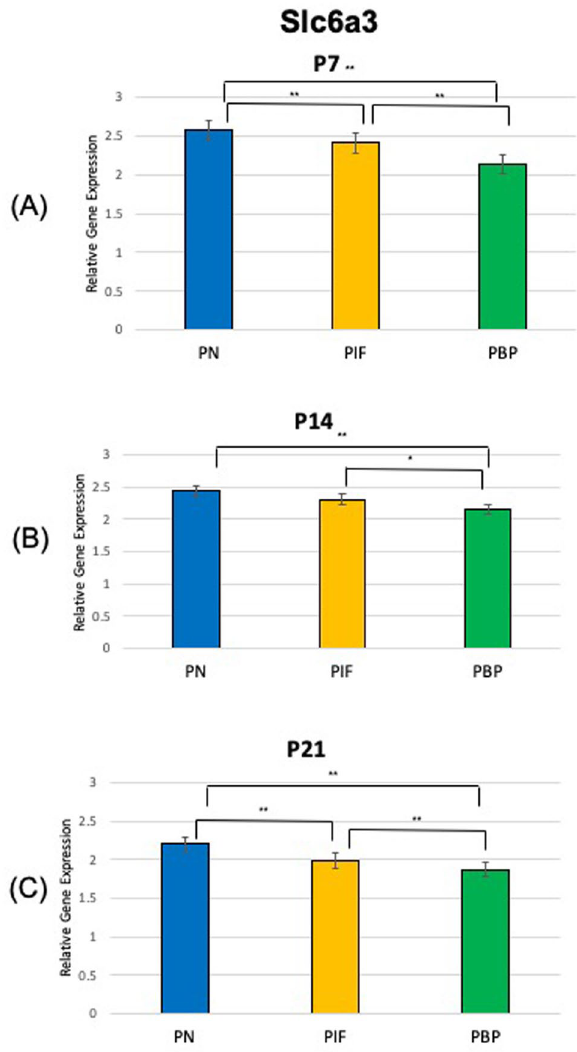
Figure 3. Relative gene expression of Slc6a3 in the VTA sub-regions (PN, PIF, and PBP) of nicotine exposed pups normalized to nicotine treated whole VTA midbrain samples. qPCR was used to identify the expression levels of DA neurons for the ( A ) P7, ( B ) P14, and ( C ) P21 day old rat pups. ***p < 0.001, standard deviation. **p < 0.01, ± standard deviation. *p < 0.05 ± standard